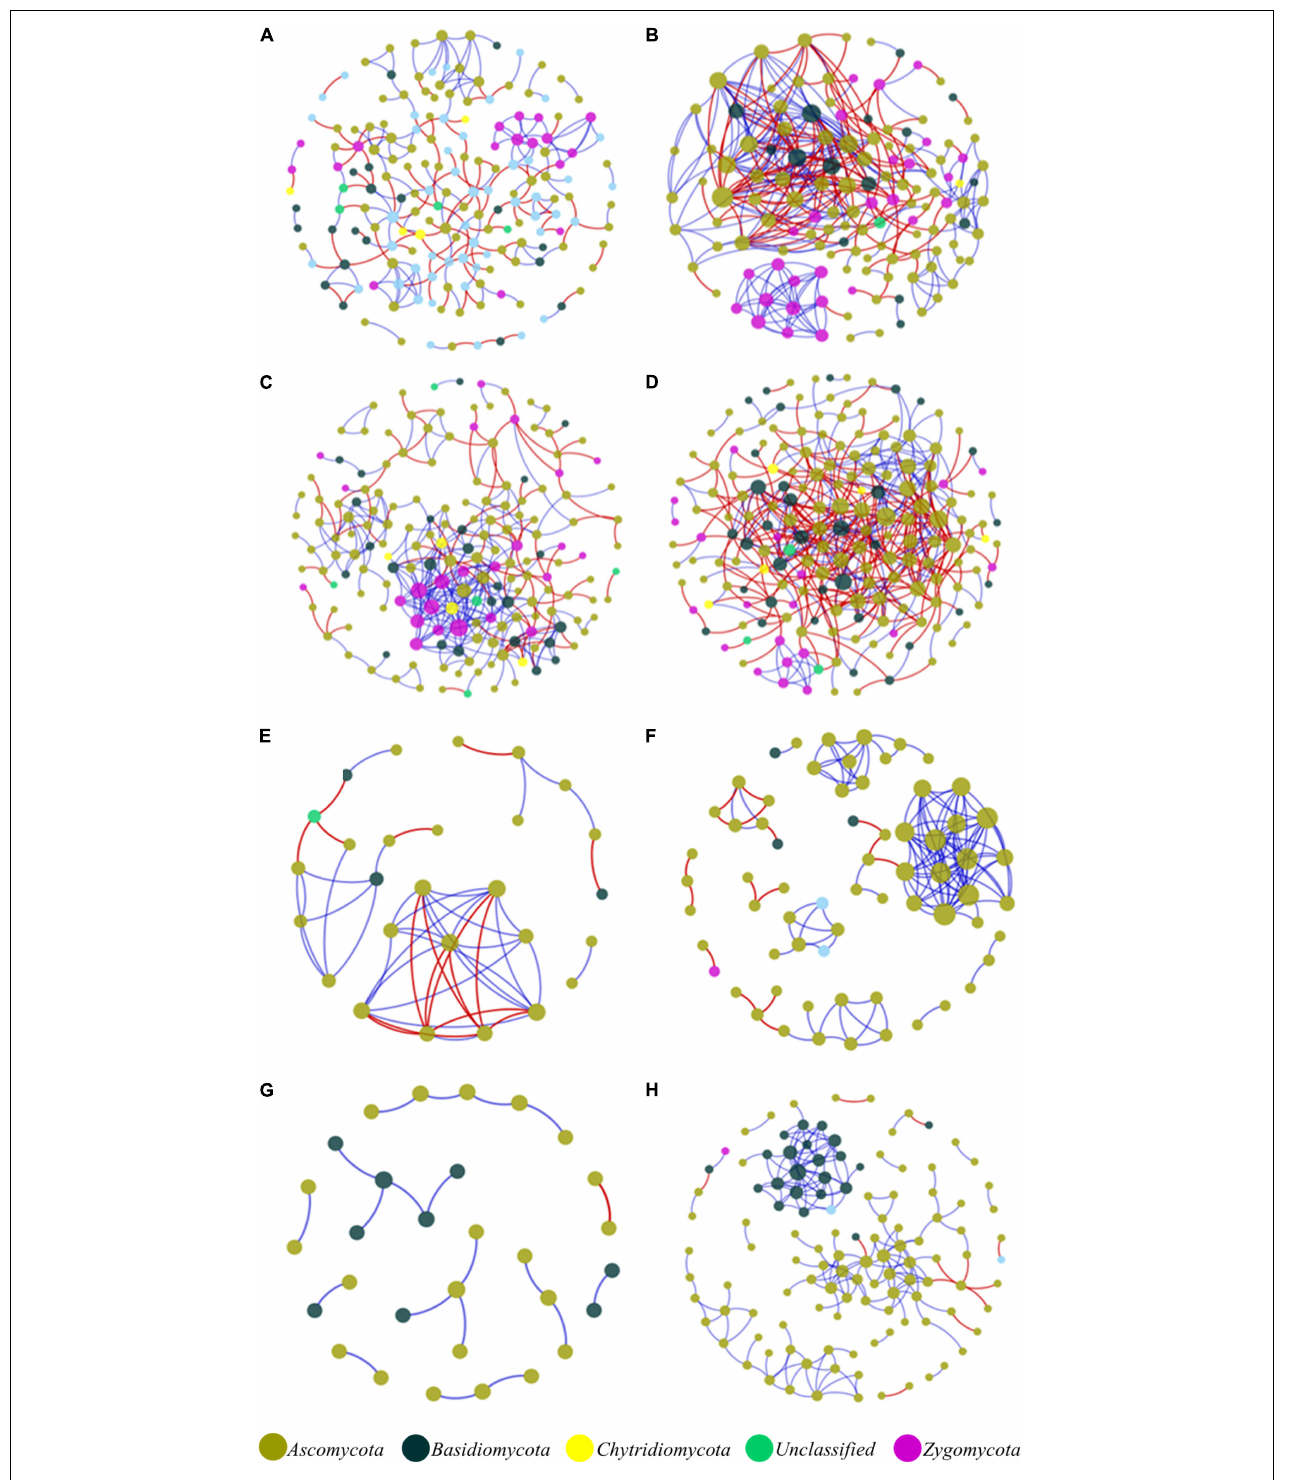
FIGURE 3 | Molecular ecological networks of microorganism associations in the fungal communities of healthy and infected samples. (A) Healthy bulk soil. (B) Infected bulk soil. (C) Healthy rhizosphere soil. (D) Infected rhizosphere soil. (E) Healthy root endophytic compartment. (F) Infected root endophytic compartment. (G) Healthy stem endophytic compartment. (H) Infected stem endophytic compartment. Node color represents phylum-level taxonomy. Blue links indicate positive correlations between nodes, and red links indicate negative correlations.